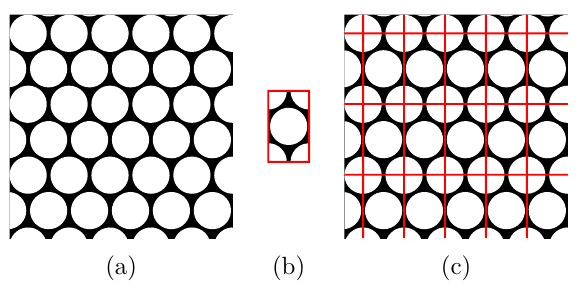
Figure 2. Modelling of periodic microstructure, a) periodic microstructure, b) PUC, c) reconstructed